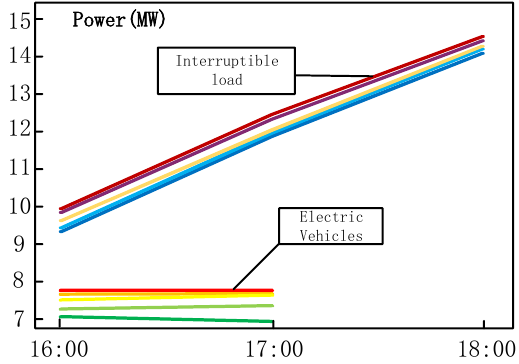
Figure 5. Fluctuating range of demand response resources.